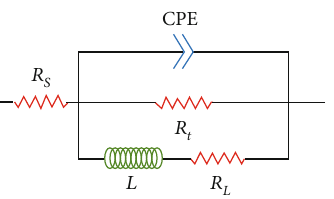
Figure 3: Equivalent electrical circuit used to model the experimental impedance data illustrated.